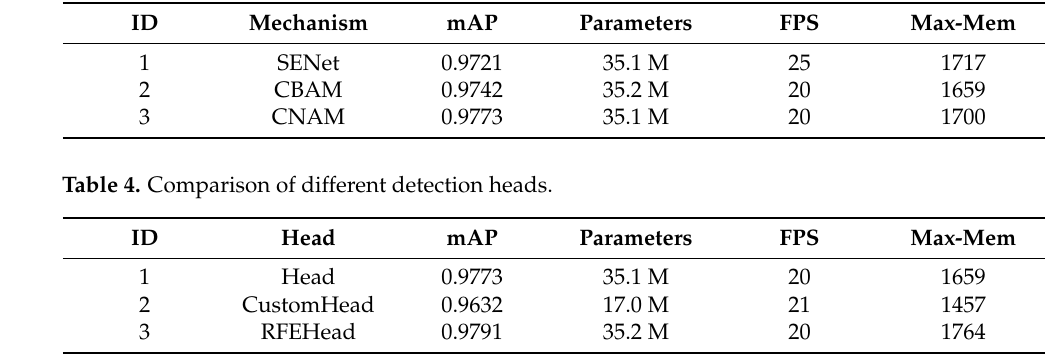
Table 3. Comparison of different attention mechanisms.